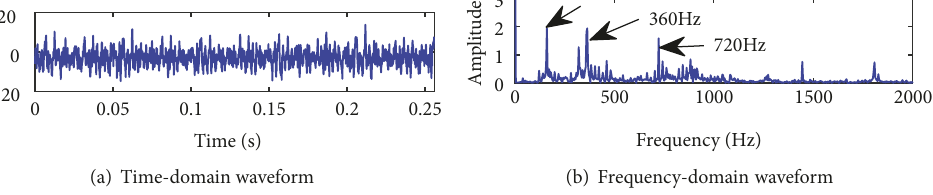
Figure 17: Fault bearing.